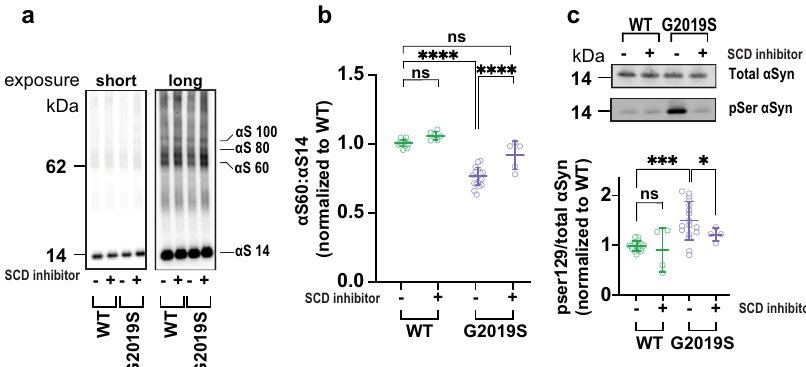
Fig. 4 Reduced tetramer:monomer ratio and increased pSer129 phosphorylation of α Syn in LRRK2 G2019S neurons are rescued by SCD inhibition. a Representative WBs of total cell lysates after intact-cell crosslinking following conditioning with ( + ) or without ( − ) 5b compound (0.5 μ M). b Quanti fi cation shows that inhibiting SCD increases the lowered α Syn T:M ratio generated by the G2019S mutation. c Quantifying phosphorylated and total α Syn in G2019S neurons with ( + ) and without ( − ) 5b treatment. Inhibiting SCD restores normal levels of α Syn phosphorylation (For both b and c , N ≥ 4 independent experiments; each dot is the average quanti fi cation of an independent six-well plate experiment; one-way ANOVA with Tukey ’ s post hoc test; error bars = SEM; * p < 0.05, *** p < 0.001, **** p < 0.0001, ns not signi fi cant).